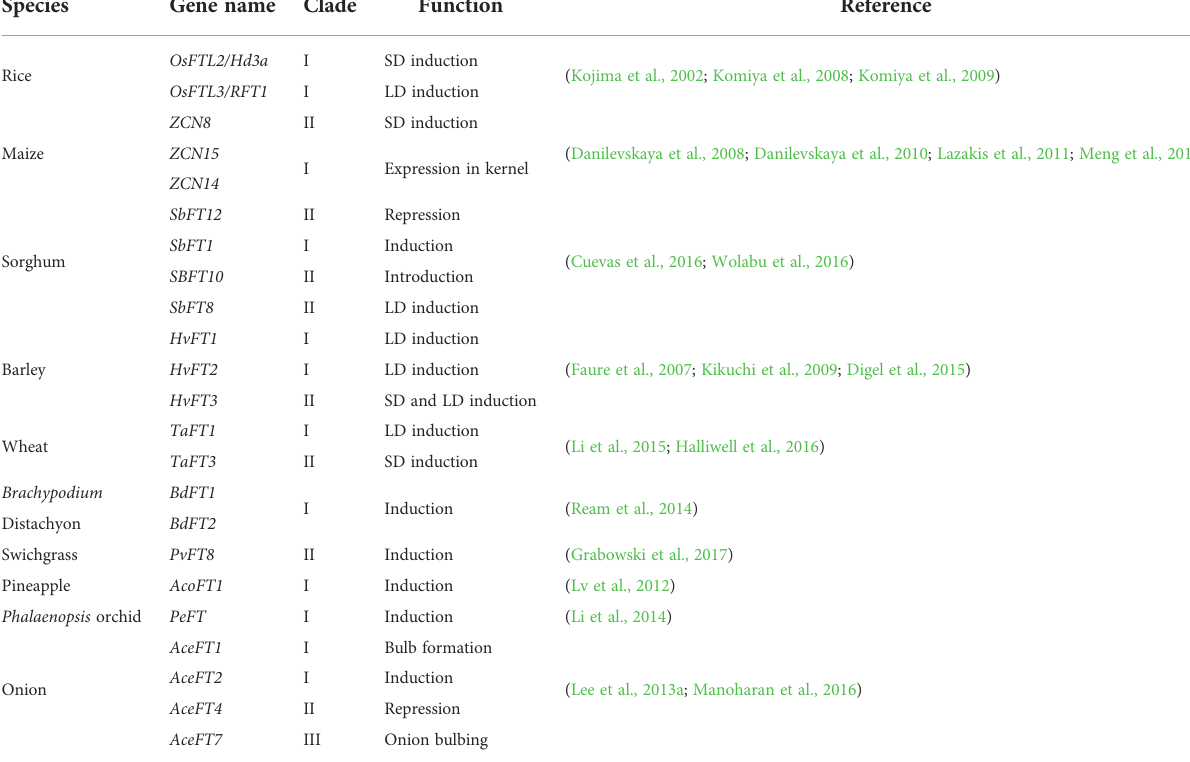
TABLE 7 FT gene in each monocot